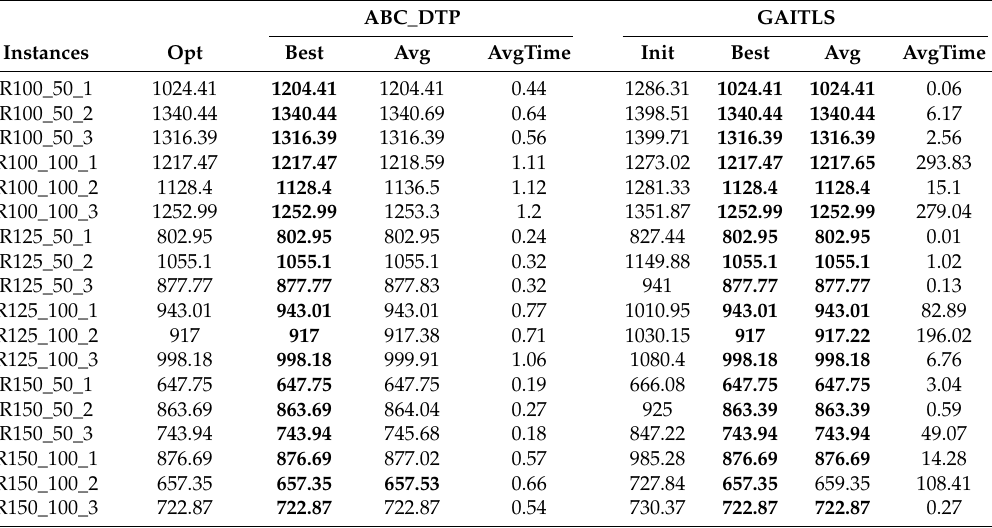
Table 3. Experimental results of ABC_DT and GAITLS on instances of